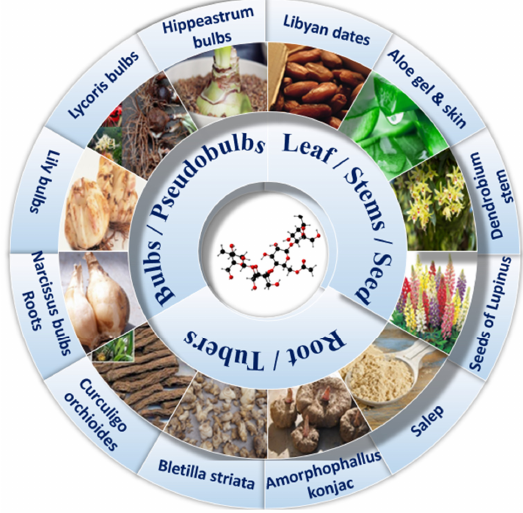
Figure 1. Glucomannan from different sources.